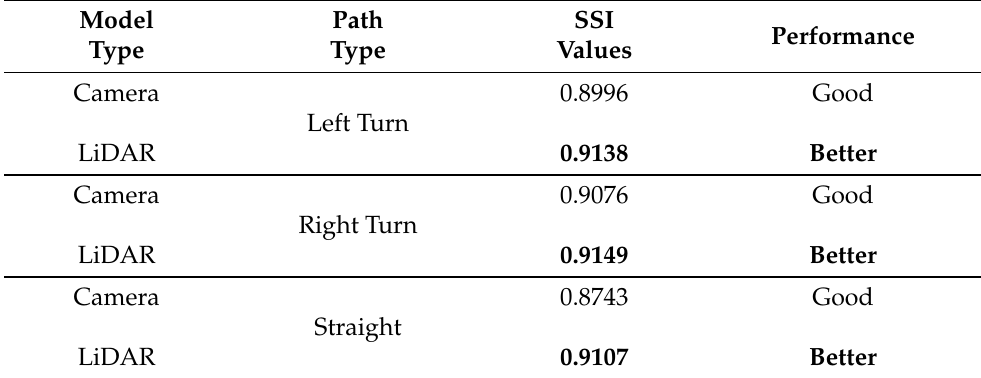
Table 4. Structural similarity index (SSIM) between the manual and model curves.